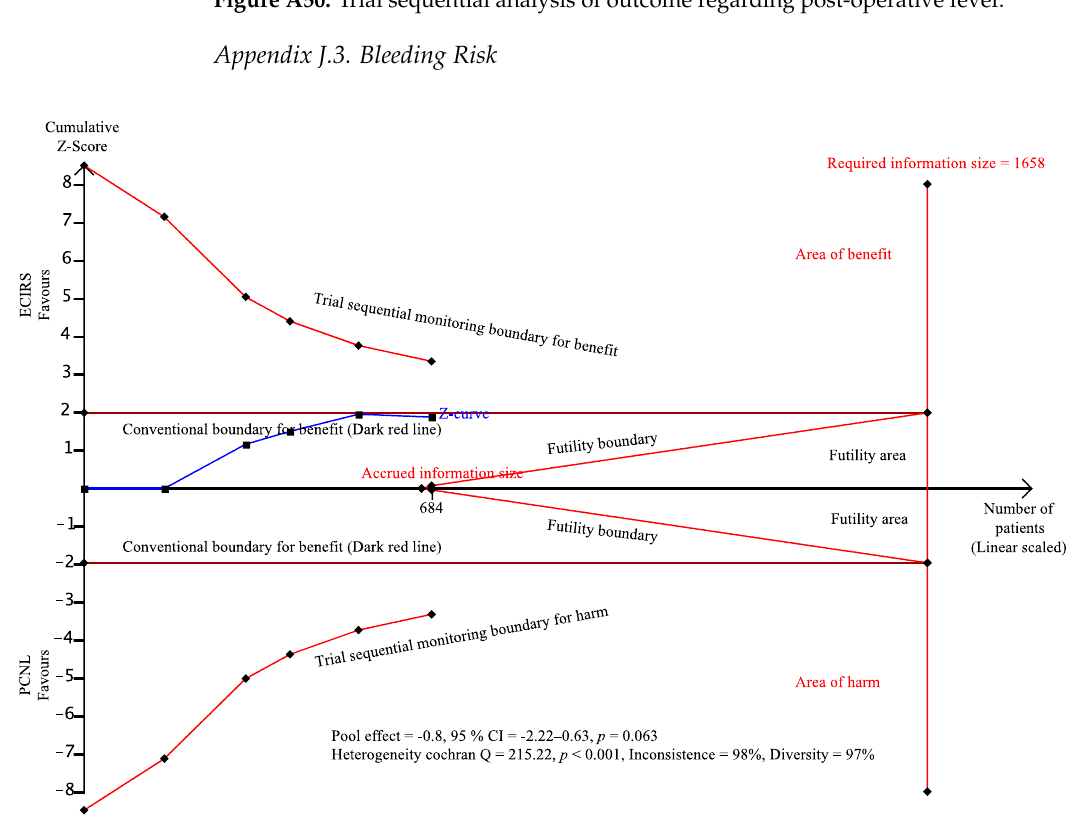
Figure A50. Trial sequential analysis of outcome regarding post-operative fever.